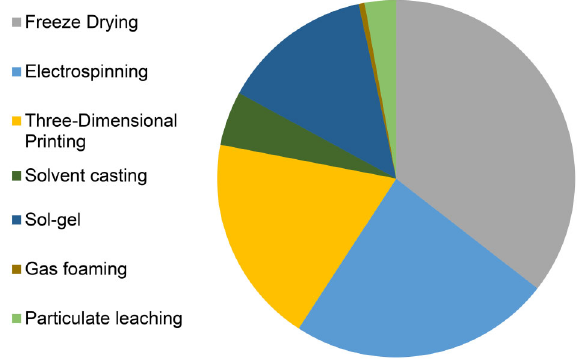
Figure 2. Distribution of manufacturing techniques cited for scaffolds with a bone regeneration objective. Each term has been associated with AND ‘‘ Bone Regeneration ’’ [MeSH]. June 1, 2020.